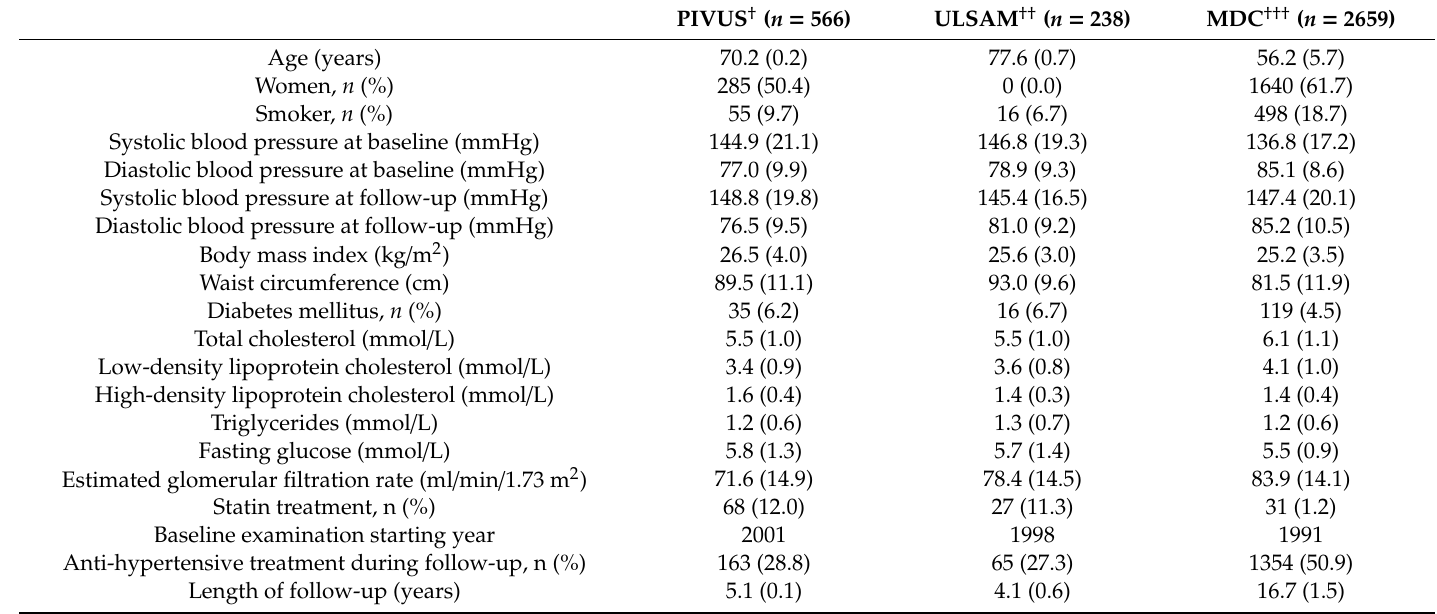
Table 1. Baseline characteristics of participants in the PIVUS, ULSAM, and MDC